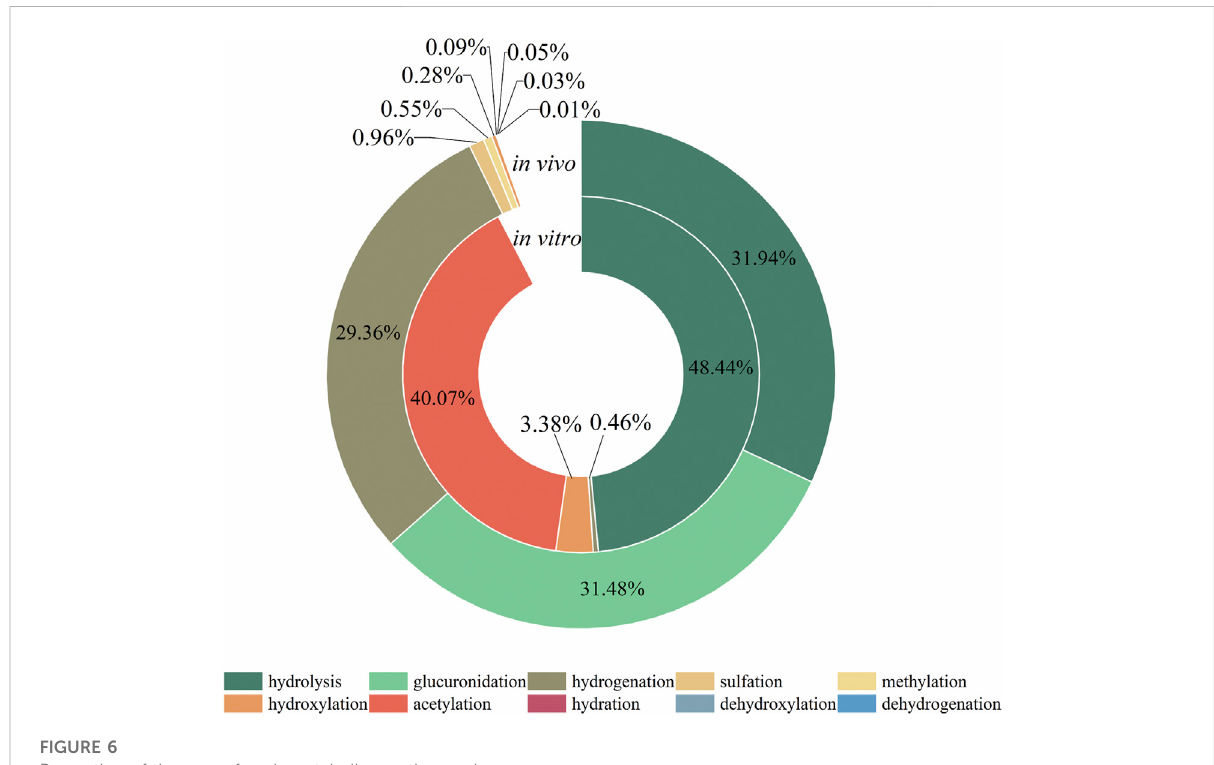
FIGURE 6 Proportion of the area of each metabolic reaction